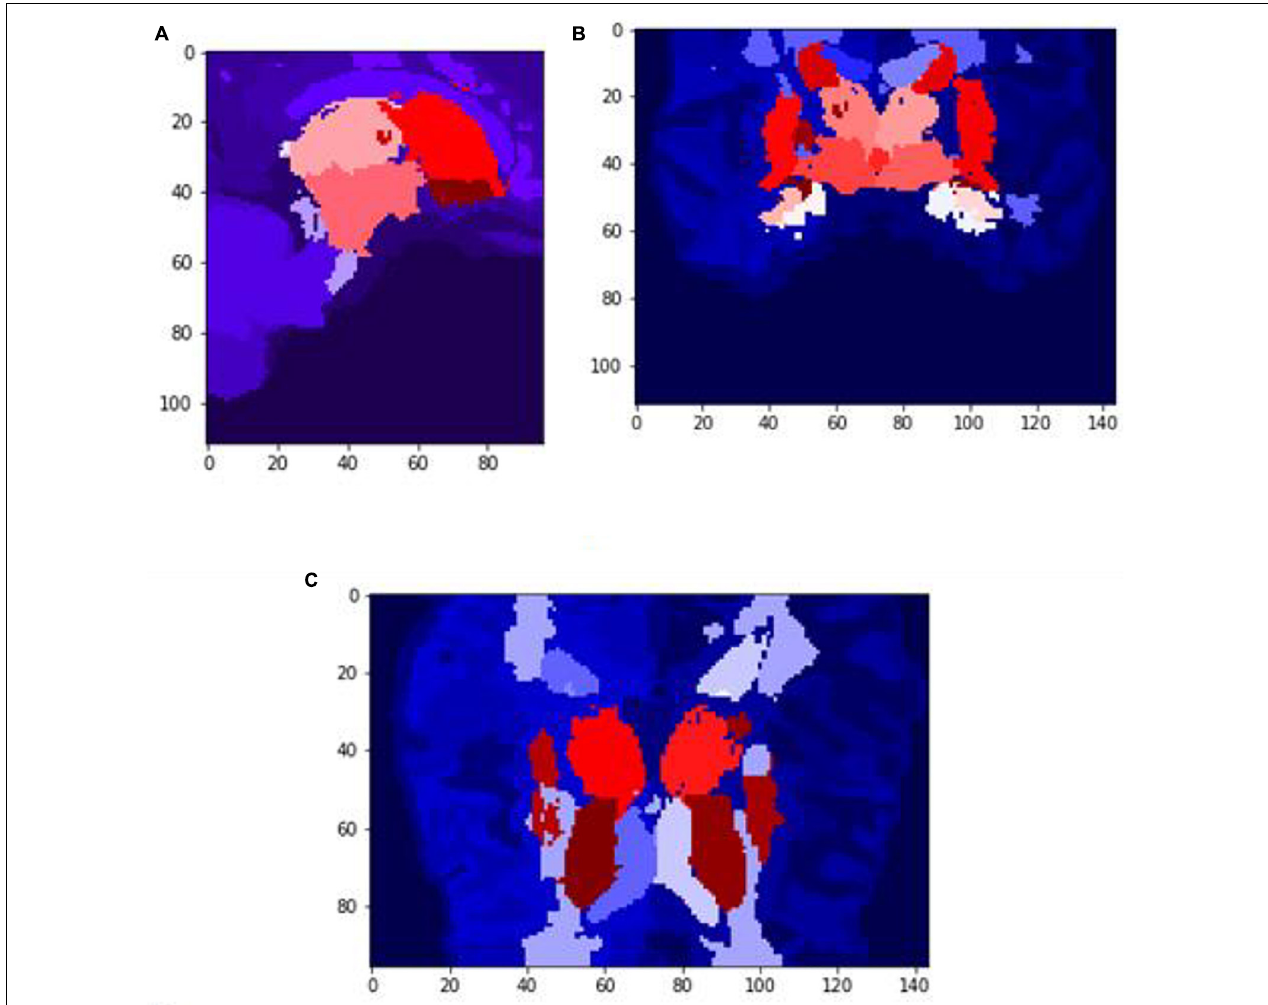
FIGURE 7 | Slices (A) Sagittal, (B) coronal, and (C) axial planes. The output of VoxelMorph of session OAS30319_MR_d0043. Each brain structure has been colored differently.rgb values. The images are shown using NiBabel library version 3.2.1 (https://zenodo.org/record/4295521#.YCpJqeqxWMI).